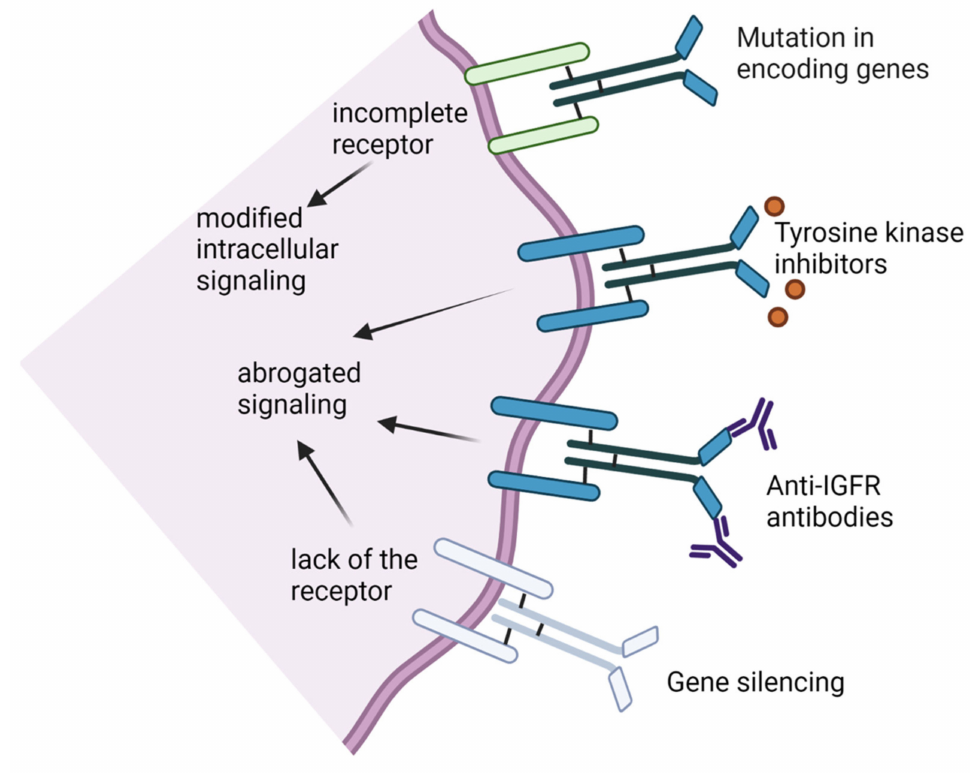
Figure 2. Various therapeutic approaches to targeting IGF-1R receptors. Mutation inducers in the gene that encodes the receptor result in proteins that lack beta-subunits (dominant-negative receptors); tyrosine kinase (TK) inhibitors that hinder intracellular signaling; anti-IGF-IR antibodies which inactivate receptor functionality; gene silencing that blocks protein expression in the transcription or translation